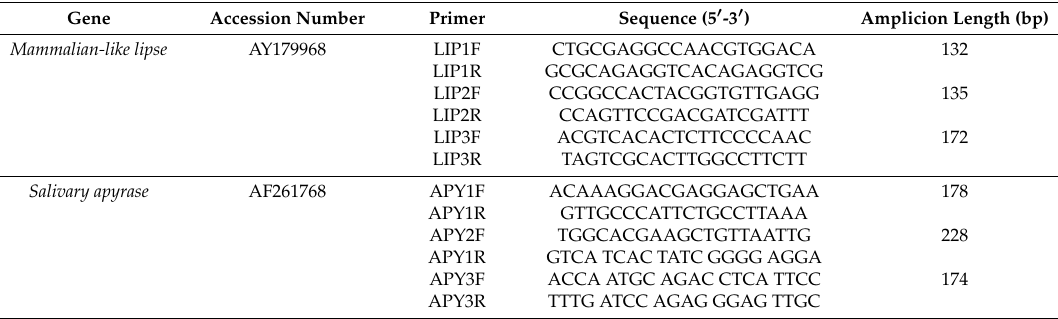
Table 1. Sequences of primer sets tested for diagnostic use, with expected amplicon